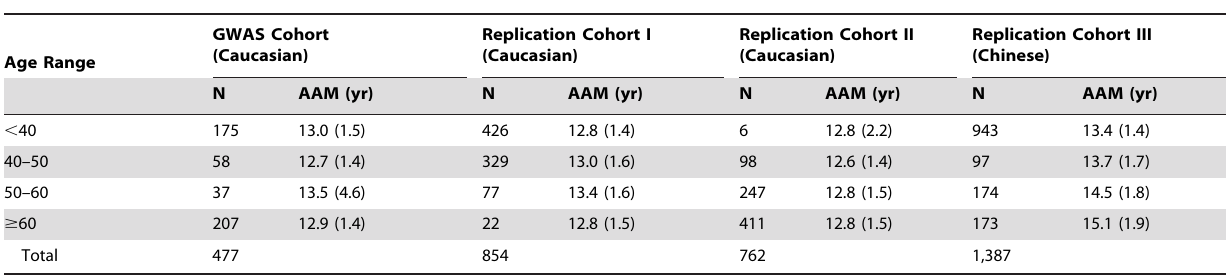
Table 1. Characteristics of the subjects for GWAS and the replication